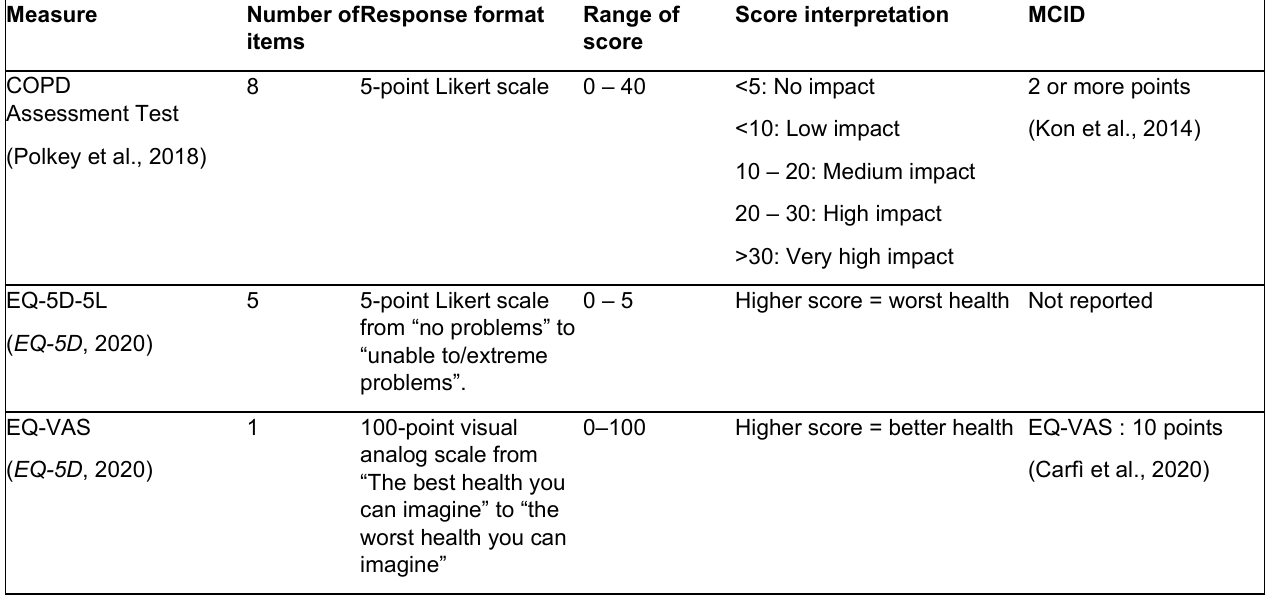
Core Outcome Set to Assess Pulmonary and Quality of Life Domains of COVID-19